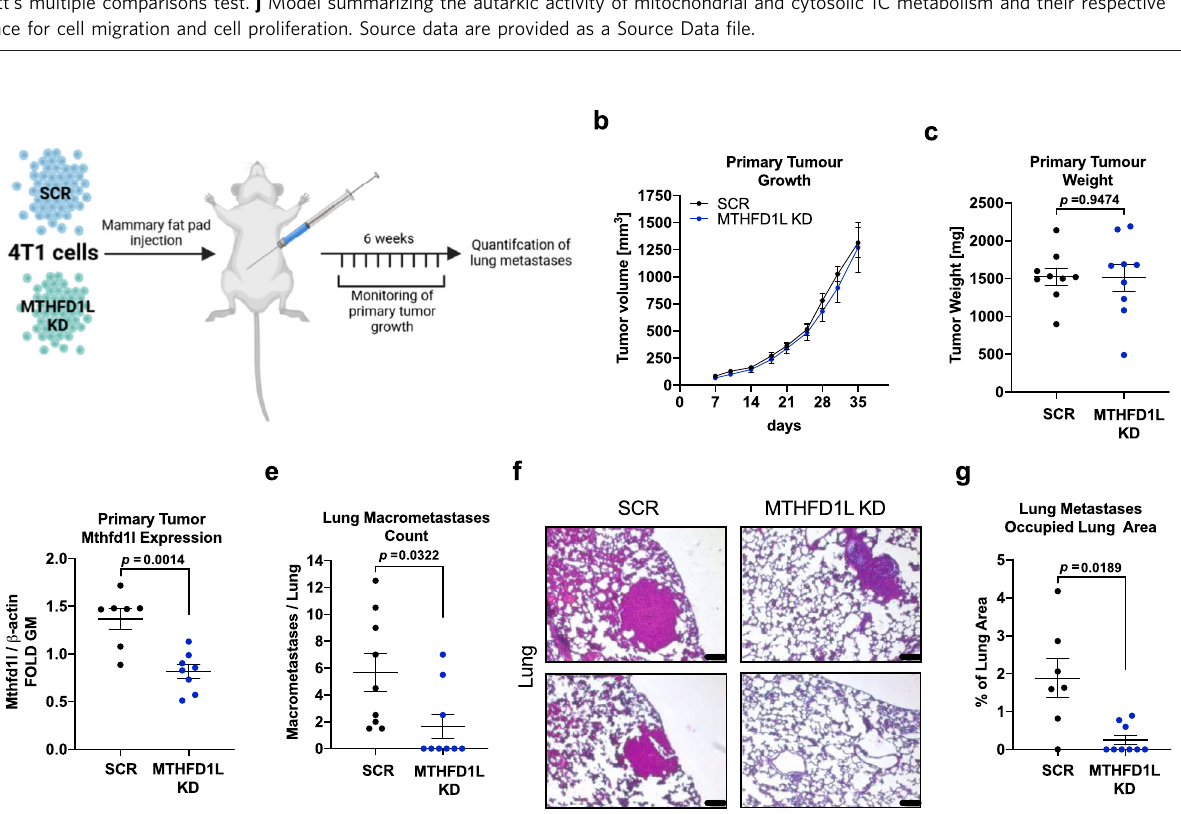
Fig. 6 Mitochondrial 1C metabolism supports cell motility and depends on mitochondrial THF availability. a Migration of MDA-MB-468 cells upon 2.5 mM Metformin and 50 nM MTX and respective AUC; mean ± SEM of independent experiments ( n = 3); Brown-Forsythe and Welch one-way ANOVA with Dunnett ’ s multiple comparisons test. b Migration of MDA-MB-468 cells upon MTHFD2 knockdown and 50 nM MTX and respective AUC; mean ± SEM of independent experiments ( n = 4); Brown-Forsythe and Welch one-way ANOVA with Dunnett ’ s multiple comparisons test. c Migration of 4T1 cells upon Mthfd2 knockdown and 75 nM MTX and respective AUC; mean ± SEM of independent experiments ( n = 3); Brown-Forsythe and Welch one-way ANOVA with Dunnett ’ s multiple comparisons test. d Migration of 4T1 cells upon Mthfd1l knockdown and 75 nM MTX and respective AUC; mean ± SEM of independent experiments ( n = 3); Brown-Forsythe and Welch one-way ANOVA with Dunnett ’ s multiple comparisons test. e Migration of MDA-MB-468 cells upon MTHFD1L knockout and 50 nM MTX and respective AUC; mean ± SEM of independent experiments ( n = 3); Brown-Forsythe and Welch one-way ANOVA with Dunnett ’ s multiple comparisons test. f ALDH1L2 and MTHFD1L protein expression in MDA-MB-468 and 4T1 cells. g Signal intensity of ALDH1L2 on Western Blot was quanti fi ed relative to β -actin as loading control. Mean ± SEM ( n = 3); unpaired t -test with Welch ’ s correction. h MTHFD1L- and ALDH1L2-dependent reactions in mitochondrial 1C metabolism. i Migration of MDA-MB-468 cells upon MTHFD1L knockout, ALDH1L2 knockdown and 50 nM MTX and respective AUC; mean ± SEM of independent experiments ( n = 3); Brown-Forsythe and Welch one-way ANOVA with Dunnett ’ s multiple comparisons test. j Model summarizing the autarkic activity of mitochondrial and cytosolic 1C metabolism and their respective